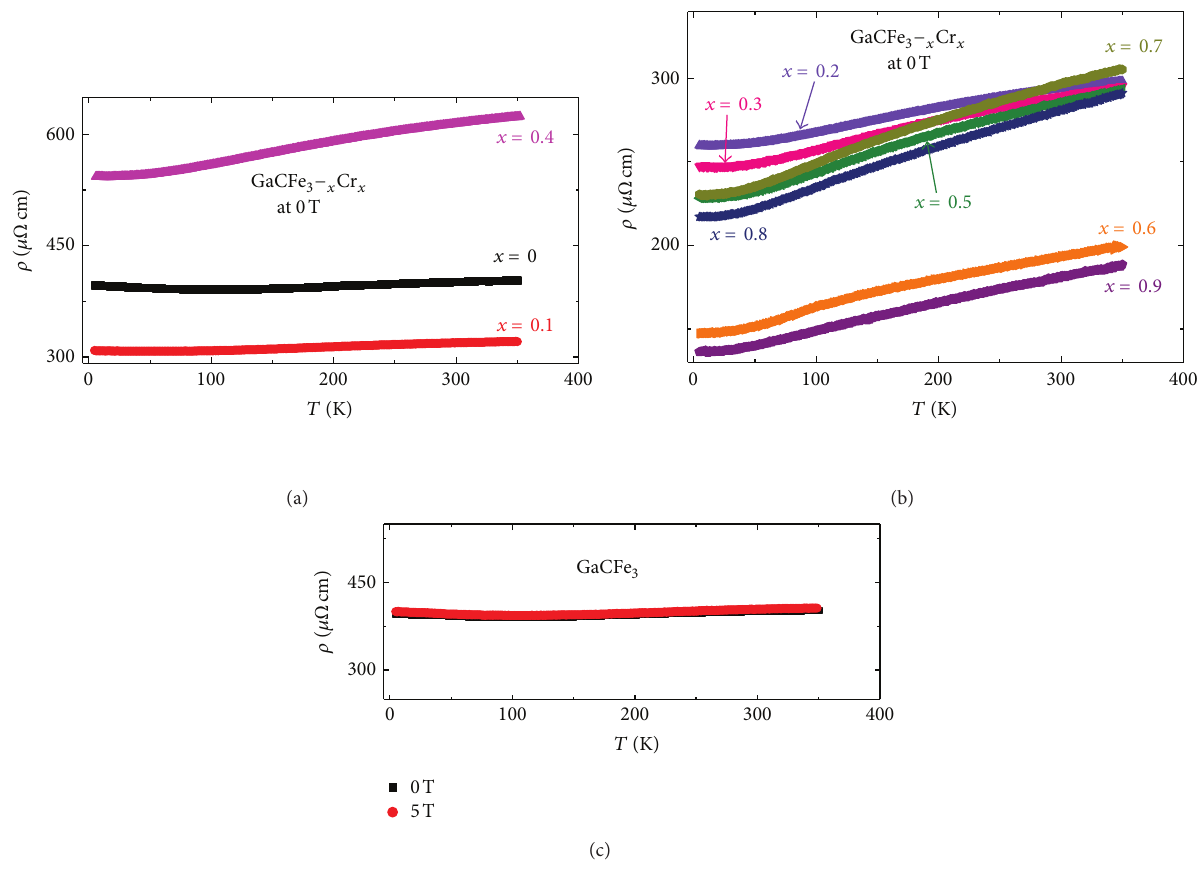
F 4: (Color online) (a)-(b) Temperature-dependent electrical resistivity at zero magnetic �eld in a temperature range of 2–350K for